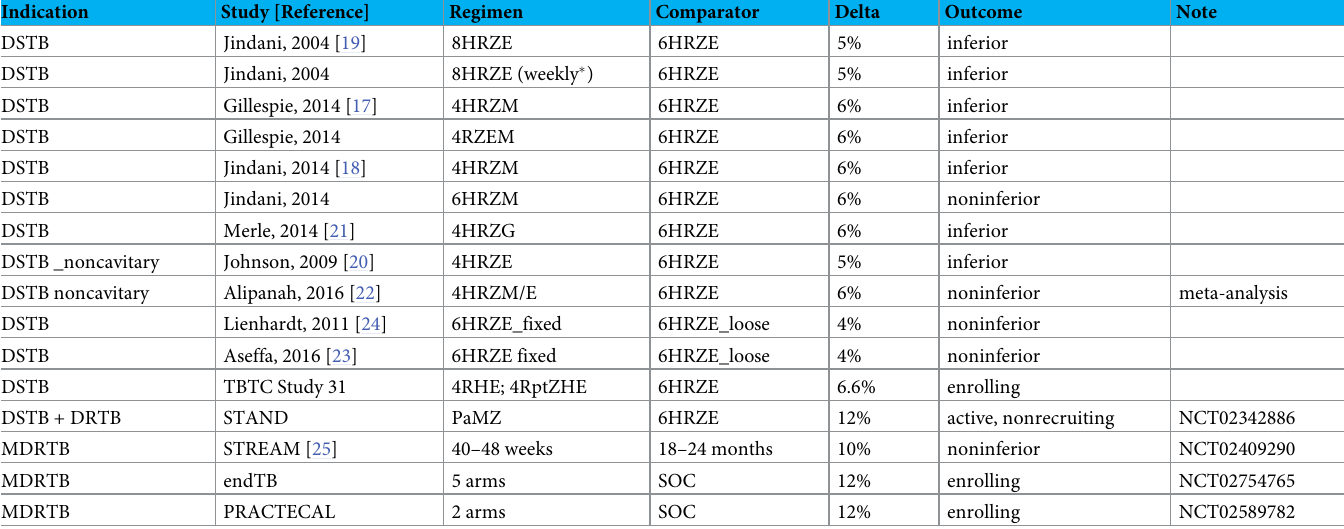
Table 1. Overview of TB noninferiority treatment trials.